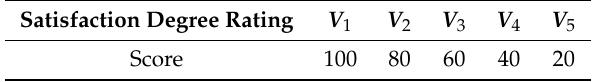
Table 10. The score of di ff erent satisfaction degree rating.